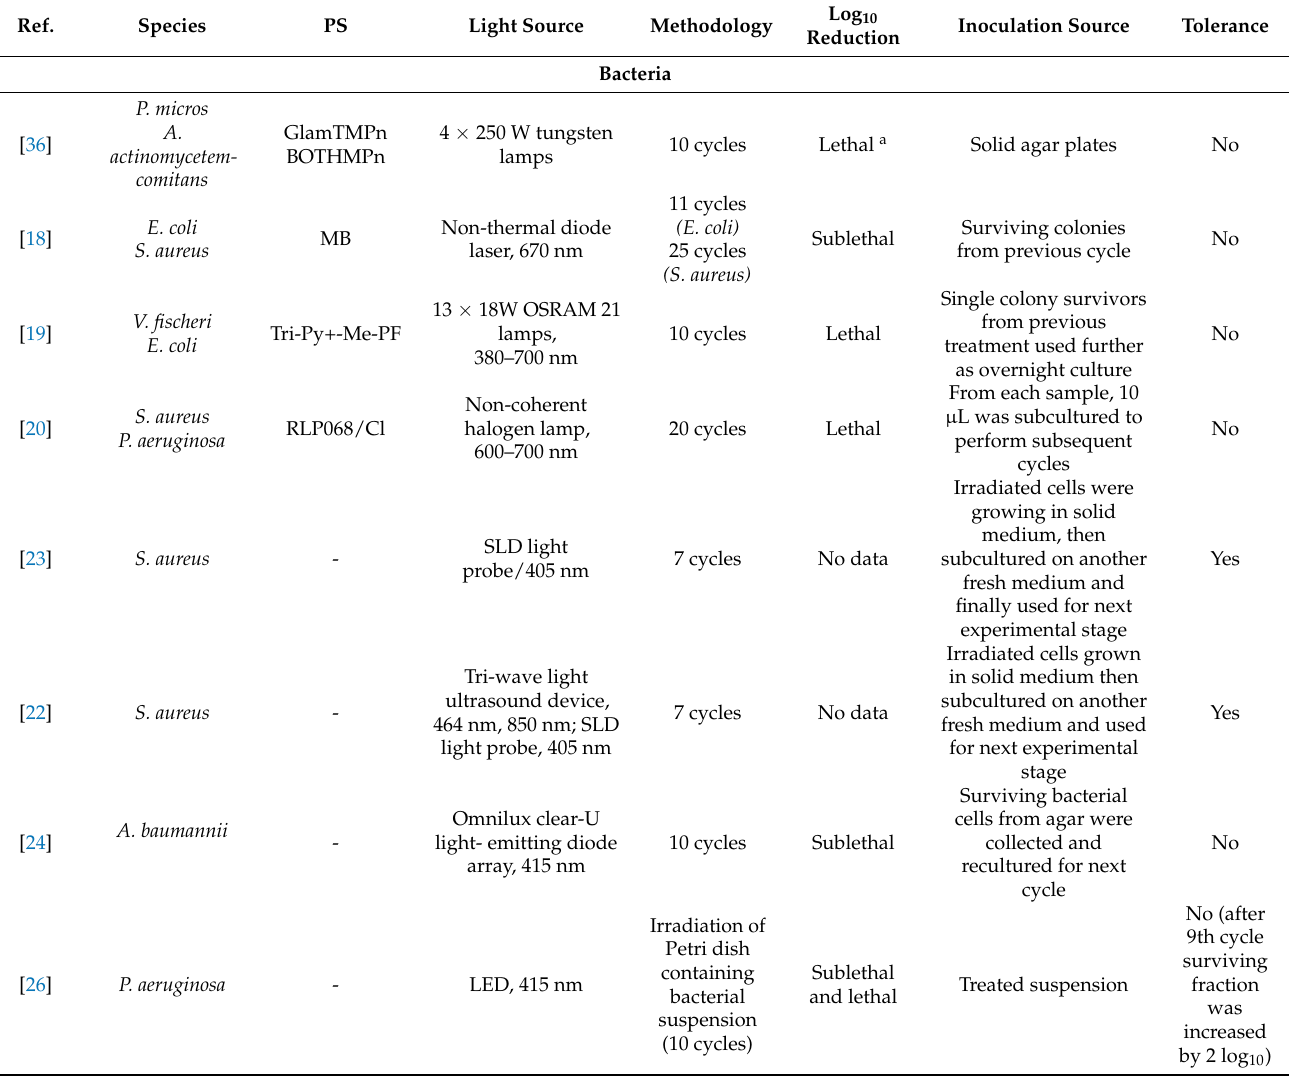
Table 1. Antimicrobial blue light (aBL) and antimicrobial photodynamic inactivation (aPDI) studies.